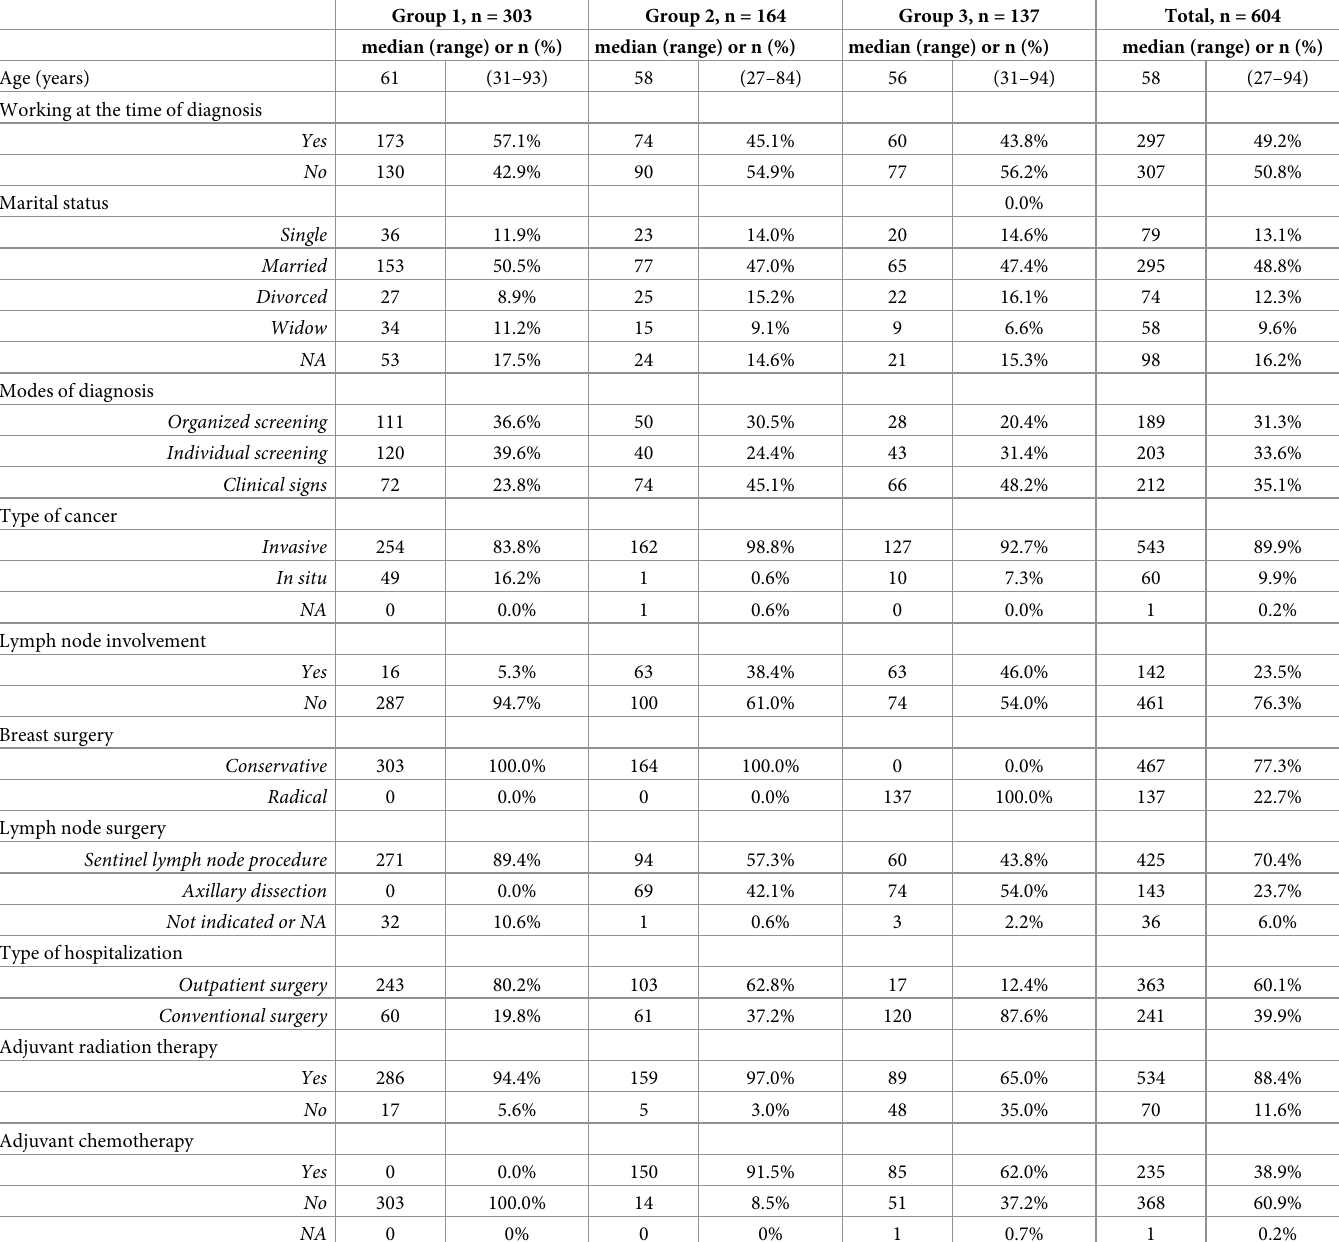
Table 1. Patients, cancer and treatments characteristics, n =